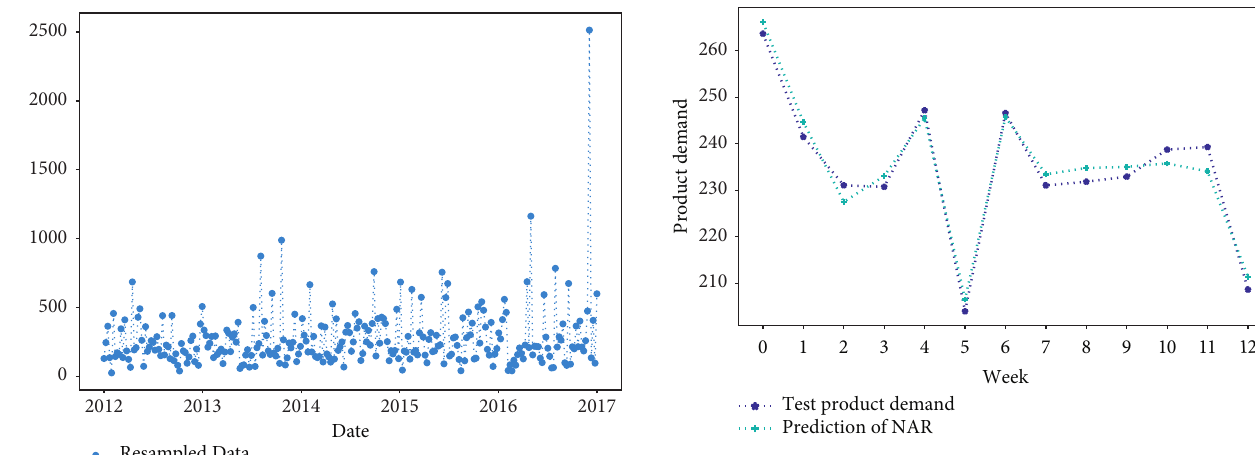
Figure 9: NAR predicted and actual